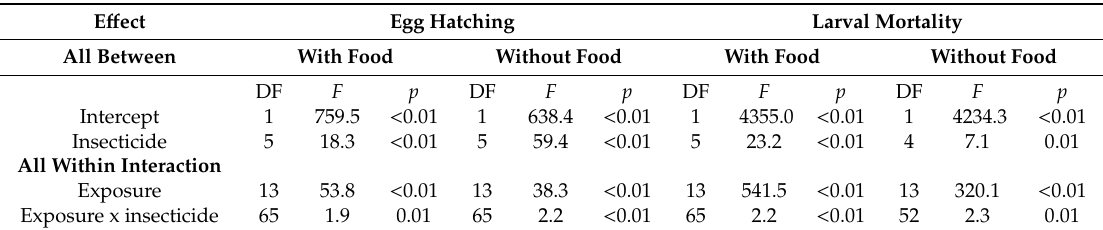
Table 1. MANOVA parameters for the main e ff ects and associated interactions for egg hatching and larval mortality of Trogoderma granarium (egg hatching total Degrees of Freedom, DF = 48, larval mortality with food DF = 47, larval mortality without food DF = 35). E ff